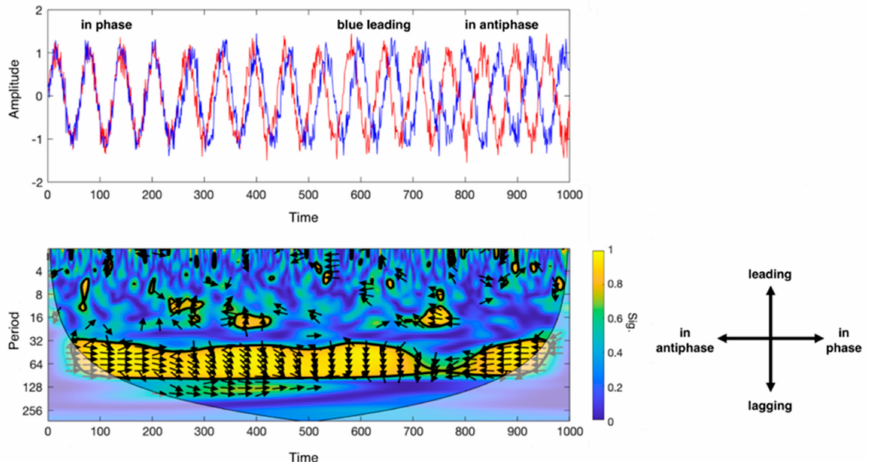
Figure 2. Description of the wavelet coherence analysis (WCA). Top left: example of phase coherence between two sinusoidal signals (in blue and red), from in-phase (on the left) to antiphase (on the right) condition during a defined set of acquisition time; bottom left: scalogram that outputs from WCA for the two sinusoidal signals. X-axis indicates the progression of time (which may be expressed in seconds, minutes or number of volumes if referred to MRI scans), y-axis the scale (in Fourier periods). The map threshold is set at 95% confidence by a thick black curve based on Monte Carlo tests. Regions outside the cone of influence appear in faded colour. Color scale reflects the statistical significance of the wavelet coherence between the two signals. The phase angle between ROI time series at a particular location in the time–frequency plane is indicated by an arrow. Bottom right: legend for the interpretation of the direction of the arrows (phase arrows). Phase arrows pointing: right—signals are in phase; left—signals are in antiphase; down—blue signal leading red signal by 90 ◦ ; up—blues signal lagging red signal by 90 ◦